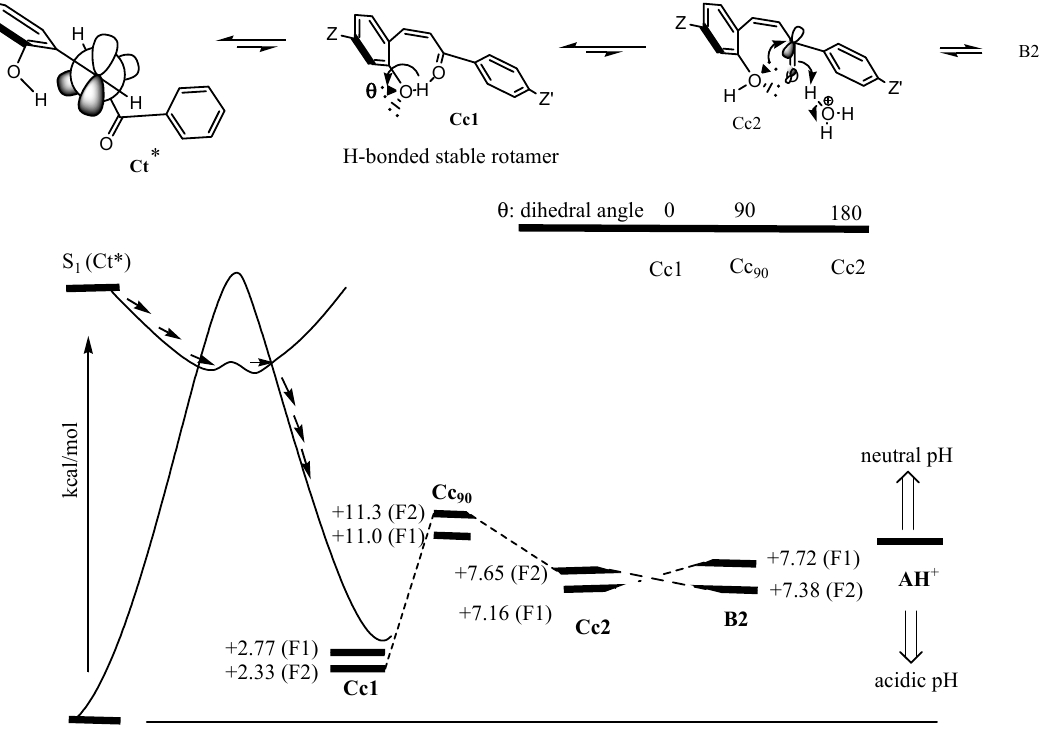
Figure 9. Schematic drawing based on the calculation for the whole process from Ct to AH + . The numbers on the schematic illustration indicate how much more energy they have compared to the energy of corresponding trans -chalcones Ct F1 and Ct F2 .